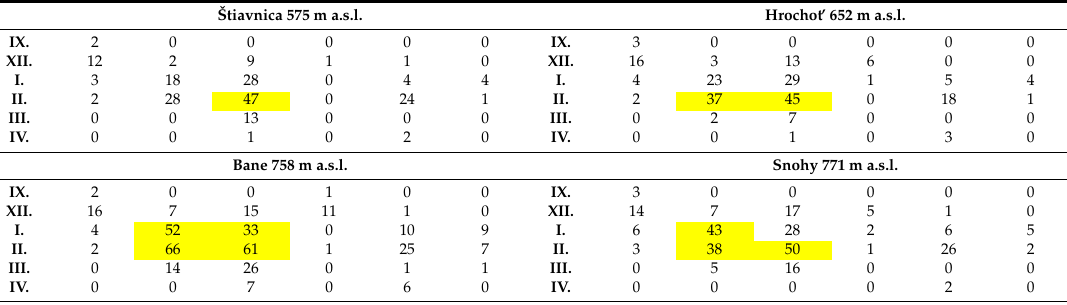
Figure 3. ( a ) Six-season mean values (mean ± SD) of monthly average snow depth at the four precipitation stations, which are sorted in ascending order according to their elevation (Štiavnica–lowest station). The horizontal dashed line indicates the depth of snow that is sufficient for skiing on natural snow (>30 cm); ( b ) The number of seasons (from the six analyzed seasons) in which the monthly average depth of natural snow cover was sufficient for skiing. Table 2. Monthly average snow depth at the four precipitation stations from the 2010–2011 to the 2015–2016 season. Values > 30 cm (sufficient natural snow depth for skiing) are highlighted in